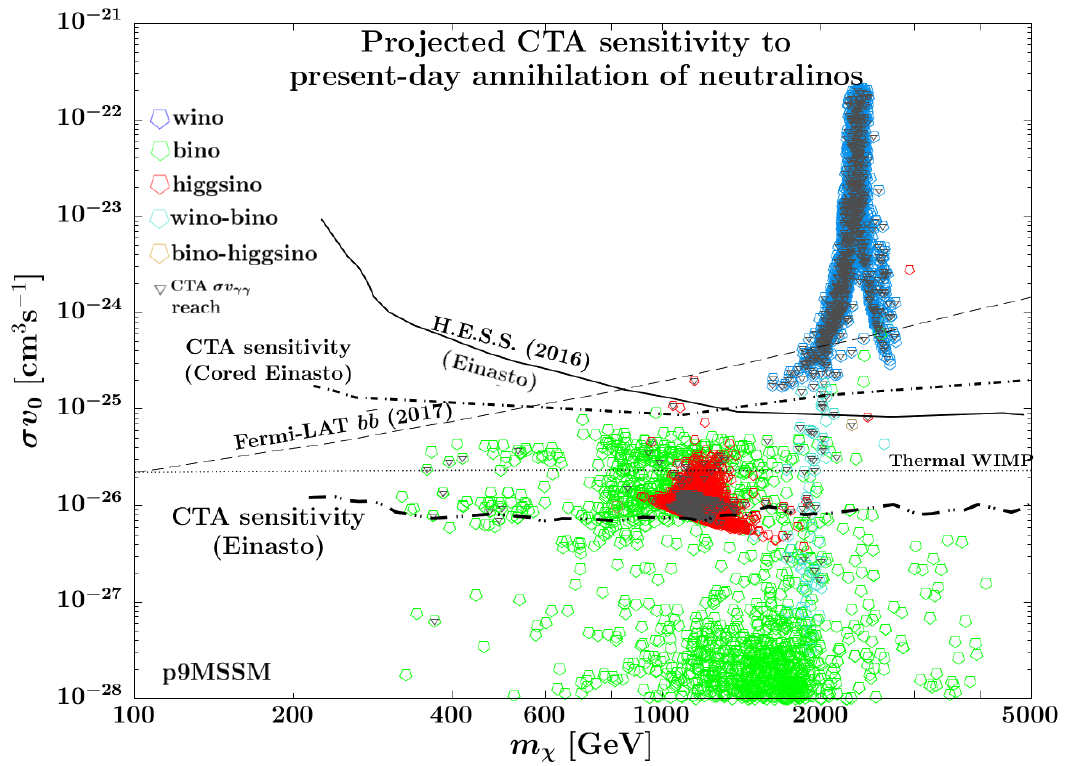
Figure 2. Distribution of p9MSSM points with (cid:1) (cid:31) 2 5 : 99 in the ( m (cid:31) , (cid:27)v 0 ) plane. The color (cid:20) coding re(cid:13)ects the composition of the lightest neutralino, as discussed in the text and according to the legend. The current upper 95% C.L. limits from H.E.S.S. [27] applied to the p9MSSM